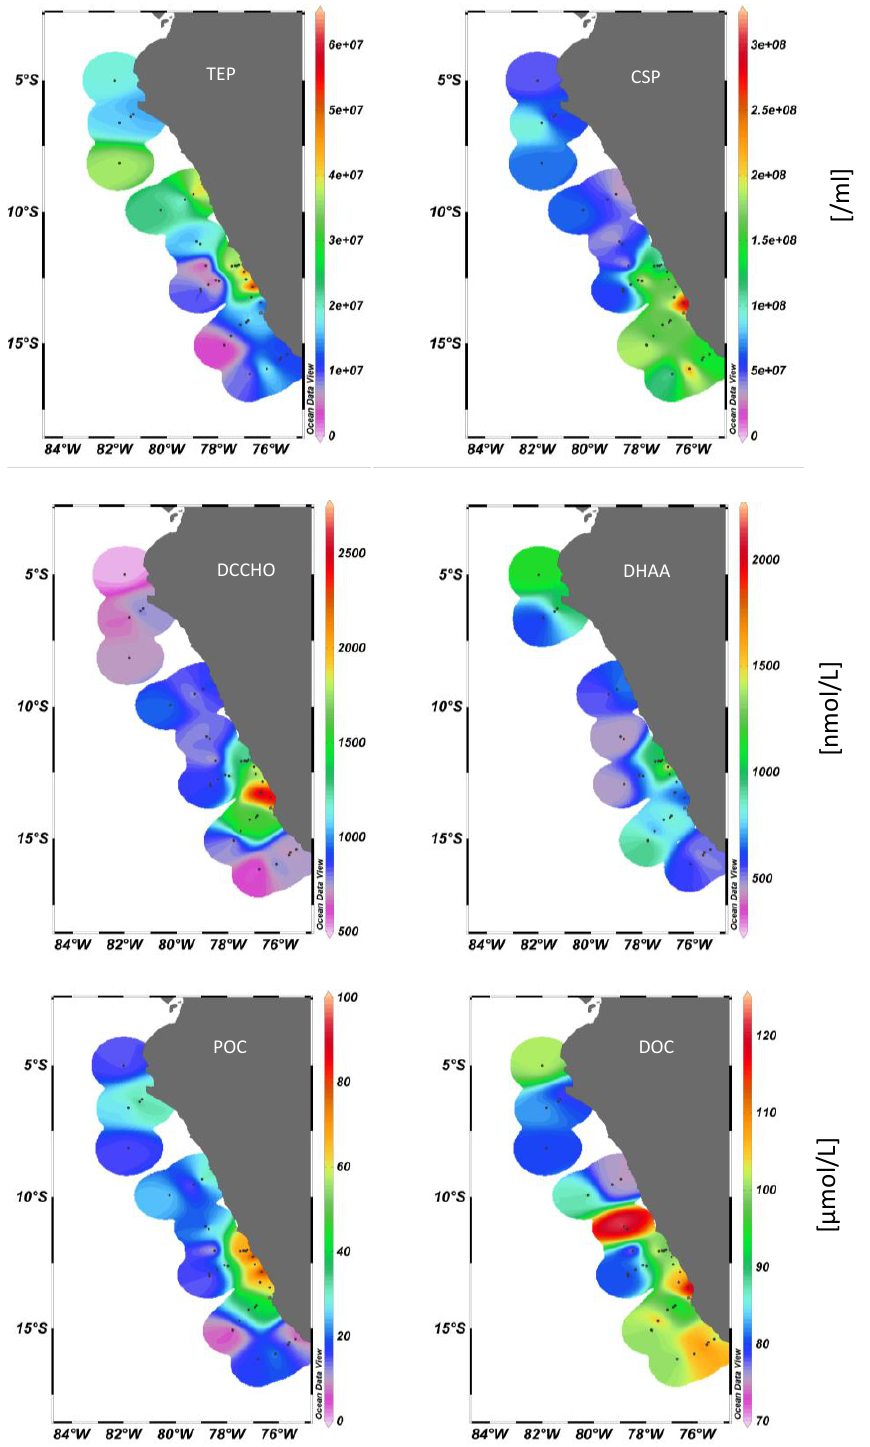
Figure 5. Surface distribution patterns of organic matter concentrations in the SML during M91 showing particulate organic carbon (POC, µmolL − 1 ) , dissolved organic carbon (DOC, µmolL − 1 ) dissolved combined carbohydrates (DCCHO, nmolL − 1 ) , dissolved hydrolysable amino acids (DHAA,nmolL − 1 ) and abundance of TEP (L − 1 ) and CSP (L − 1 )